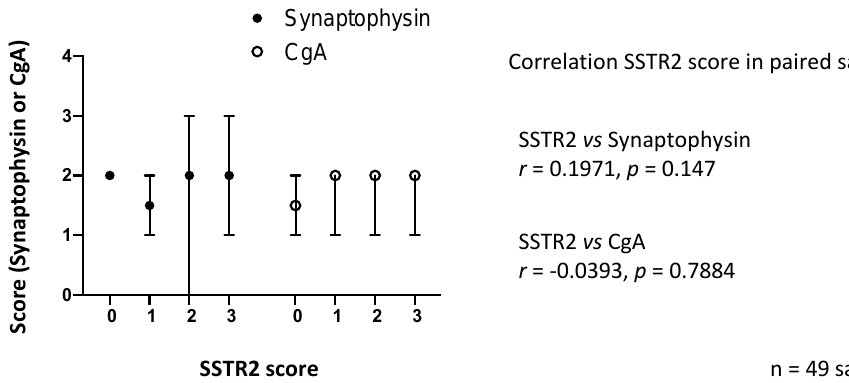
Figure 5. Synaptophysin (syn) and Chromogranin A (CgA) staining intensity compared with SSTR2 expression in a subset of samples ( n = 49). Staining intensity was consistent among samples regardless of SSTR2 expression level. Dots and bars indicate medians and ranges, respectively. Spearman rank correlation.